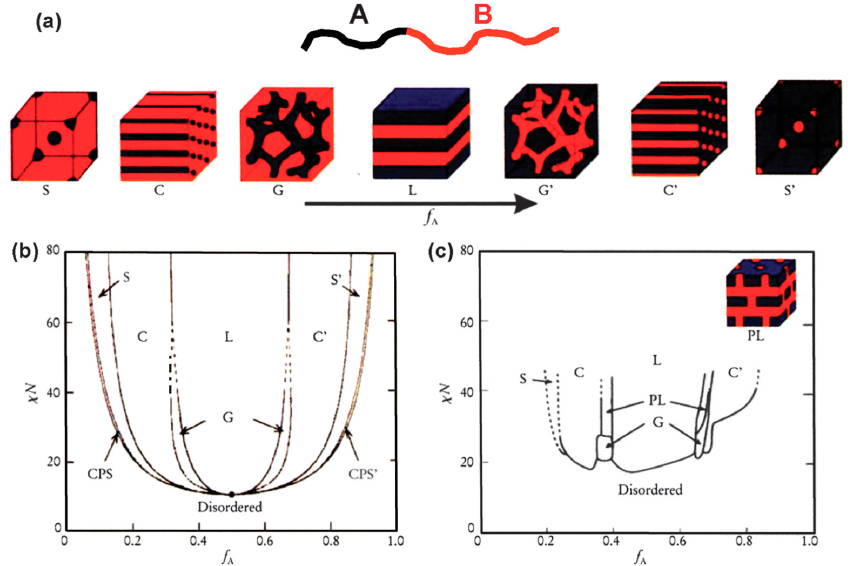
Figure 7. ( a ) Equilibrium morphologies of AB diblock copolymers in bulk: S and S’ = body-centered-cubic spheres, C and C’ = hexagonally packed cylinders, G and G’ = bicontinuous gyroids, and L = lamellae. ( b ) Theoretical phase diagram of AB diblocks predicted by the self-consistent mean-field theory, depending on volume fraction ( f ) of the blocks and the segregation parameter, χ N; CPS and CPS’ = closely packed spheres. ( c ) Experimental phase diagram of polystyrene- b -polyisoprene copolymers, in which f A represents the volume fraction of polyisoprene, PL = perforated lamellae. Reproduced from Reference [69]. (Copyright (2012) Royal Society of Chemistry).